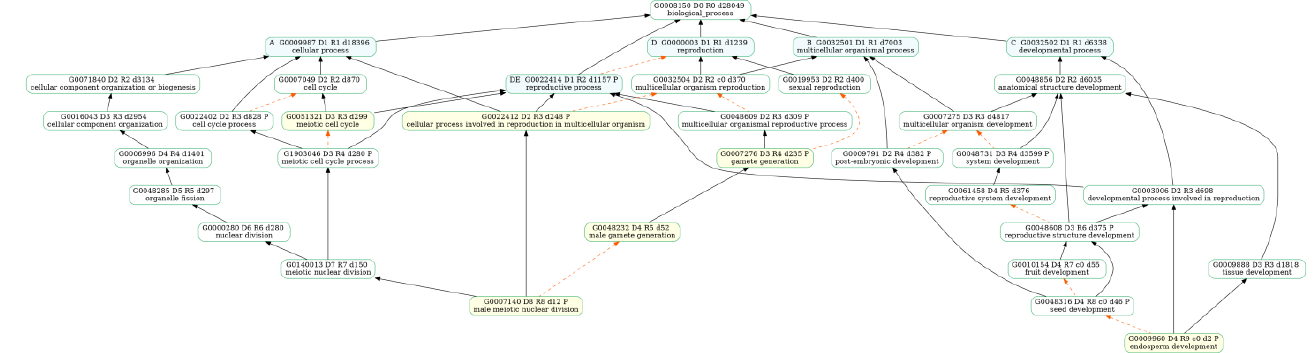
Figure 6. GOATOOLS [40] analysis of the hierarchical graphs of enriched GO biological processes in the early stage of male flower buds. Hierarchical relationships indicate that the resulting enriched GO terms (yellow) can be associated with reproductive processes (blue).